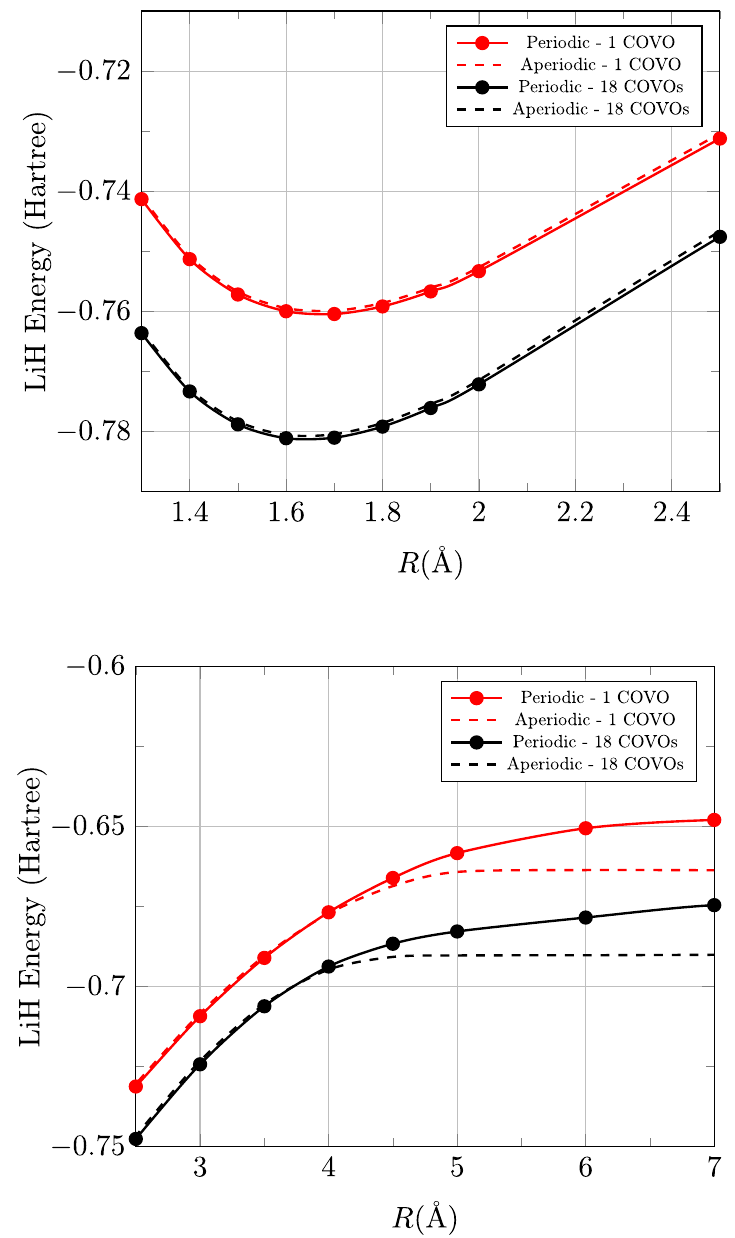
Fig. 2 Total energies as a function of distance from aperiodic and periodic plane-wave FCI calculations for the LiH molecule with 1 and 18 correlation optimized virtual orbitals. The top plot shows energy from R Å to R 2.5 Å, and the bottom plot shows energy from R = simple-cubic supercell (L 15.0 =